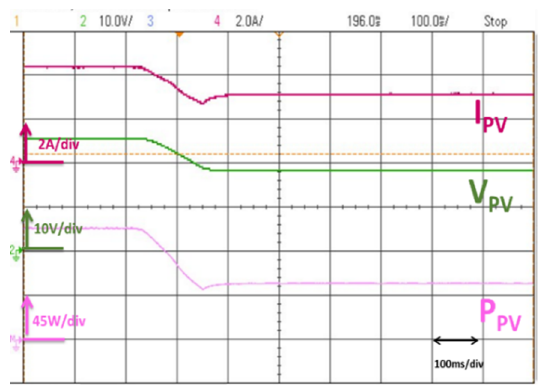
11 of 15 Figure 13. PV voltage current and power for the proposed Fixed-Frequency predictive MPPT (P max =115 W) (Ch2 (green) is PV voltage, Ch4 (pink line) is the PV current), the PV extracted power (lavender line). To prove the validity of the proposed MPPT technique under partial shading conditions and abrupt change in solar radiation conditions, a partial shading test and abrupt change in solar radiation test are performed, illustrated in Figure 14 and Figure 15. In the partial shading case of study, depicted in Figure 14, a part of the real PV module is under lower radiation comditions. The radiation level and the maximum monitored available power were found to be 55 W. As the figure